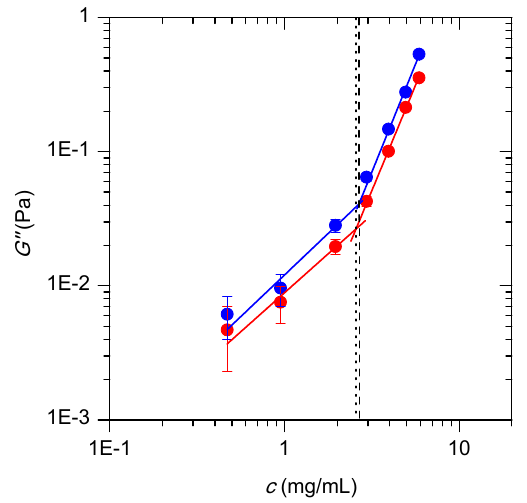
Figure 2. Viscous modulus G ’’ versus HA concentration in model HA solutions at 37.5 °C (red curve) and at 25 °C (blue curve) as derived from Time Sweep experiments.